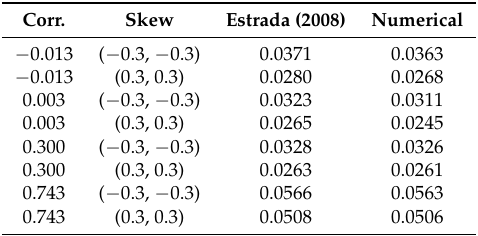
Table 1. Downside deviation of minimum semivariance portfolios with multivariate skew normal returns and 240 months rolling windows. Benchmark = risk-free rate (0.1%). Corr.